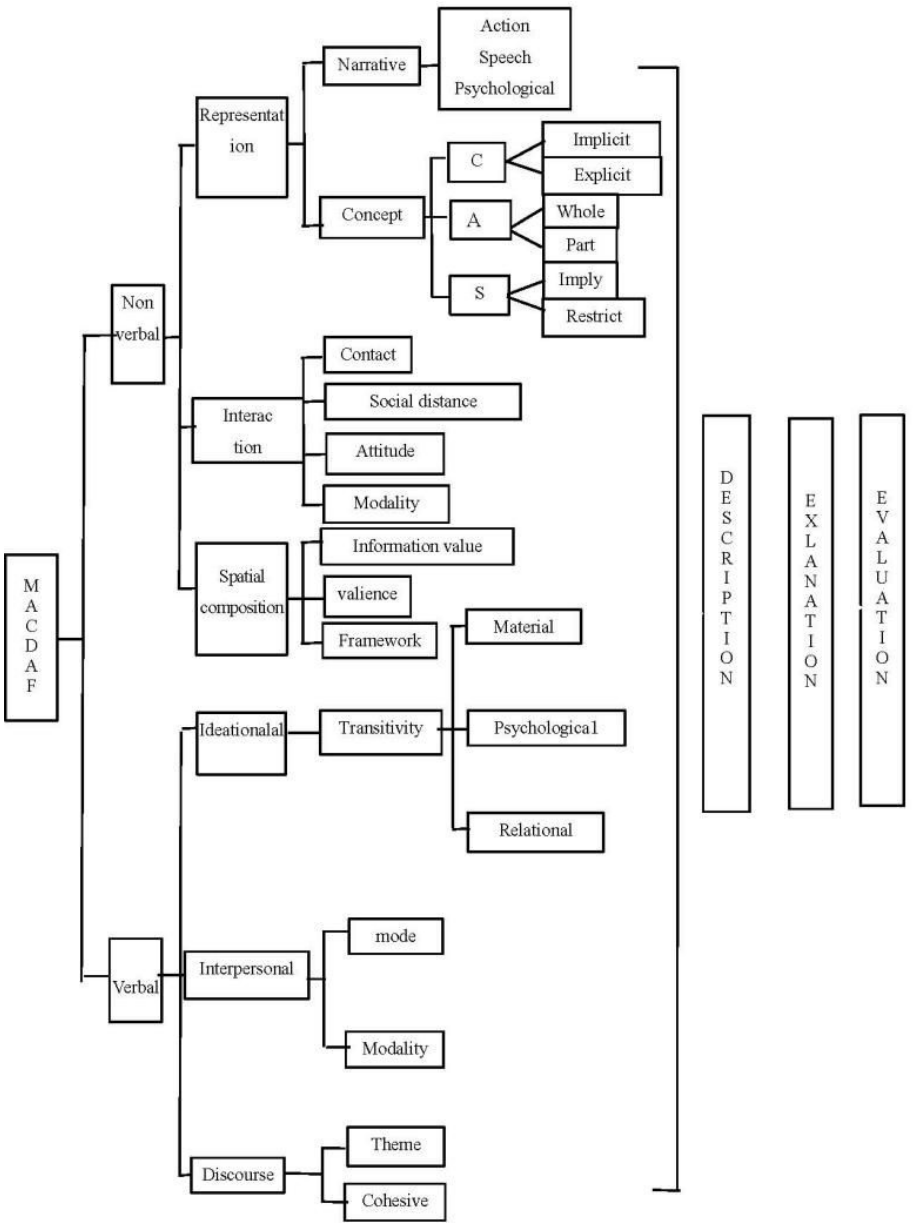
Fig. 1 MACDAF version 2. MACDAF, multimodal aesthetic criticism discourse analysis